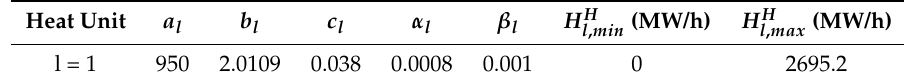
Table 3. Data of heat only unit.